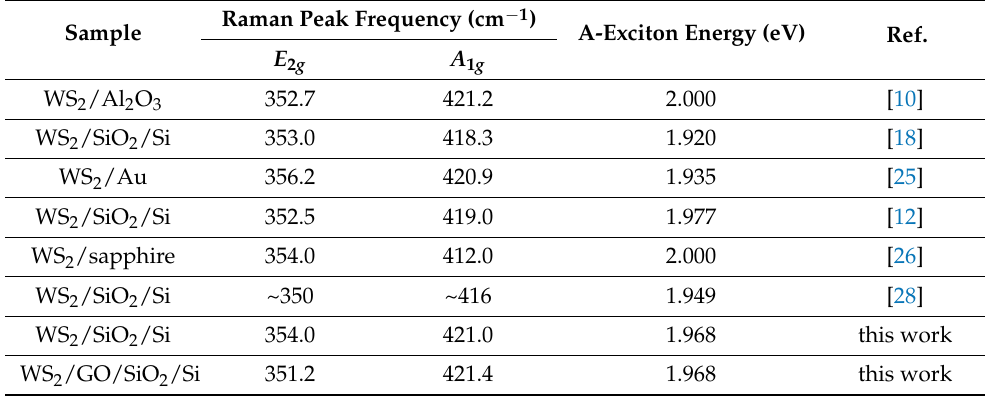
Table 3. Summary of optical properties of WS 2 nanoflakes deposited on different substrates. Sample